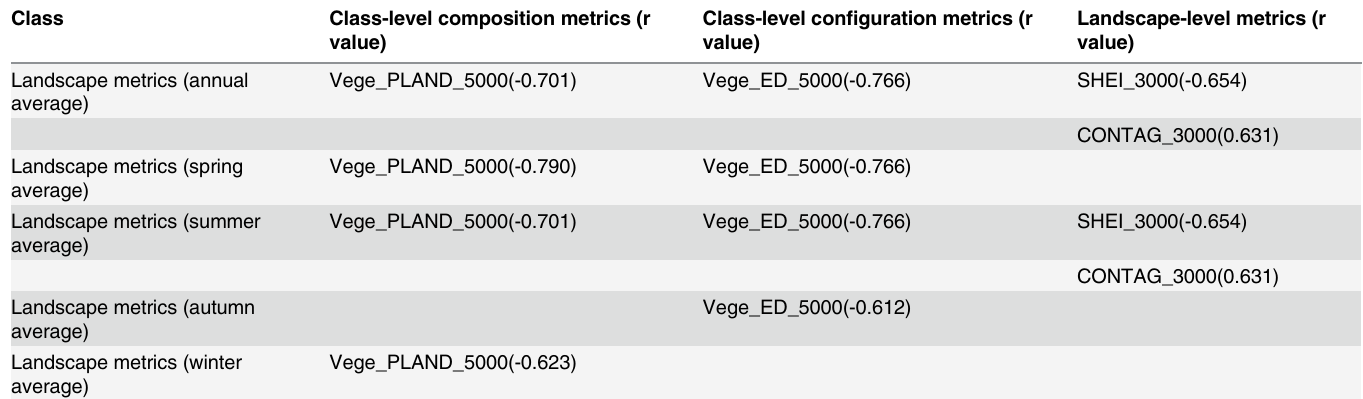
Table 3. Landscape metrics that had relationship with PM 2.5 concentration (| r | >